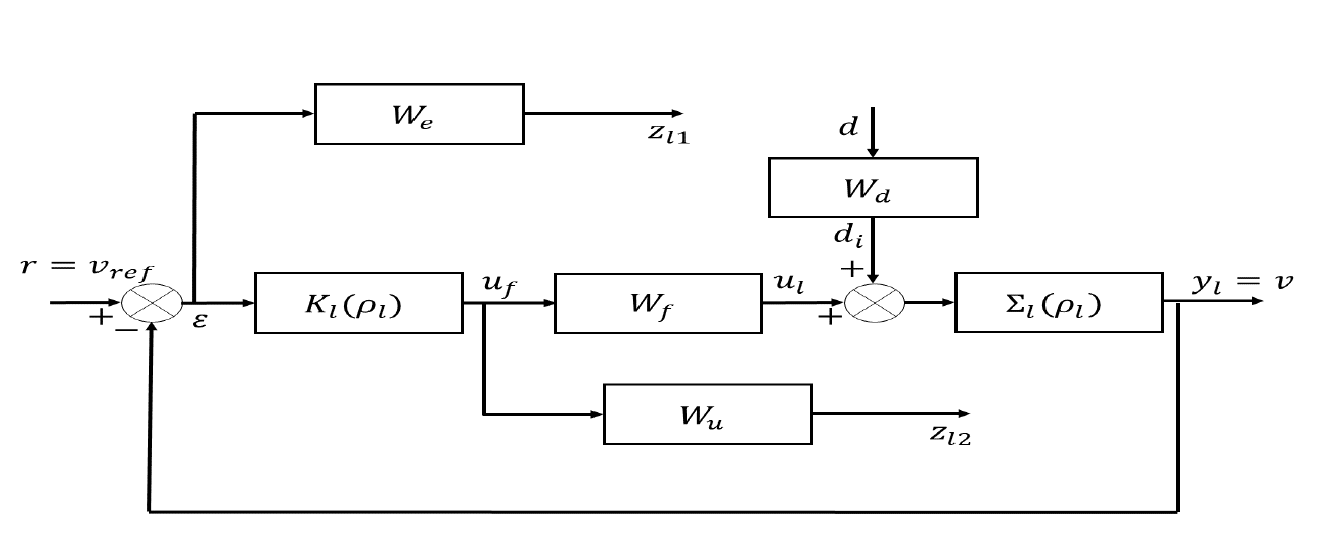
Figure 9. LPV cruise control generalized system Σ gl ( ρ l )